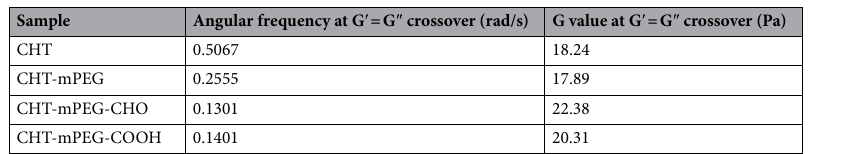
Table 5. Rheological parameters obtained from oscillation frequency sweep tests conducted on CHT/mPEG blend solutions.